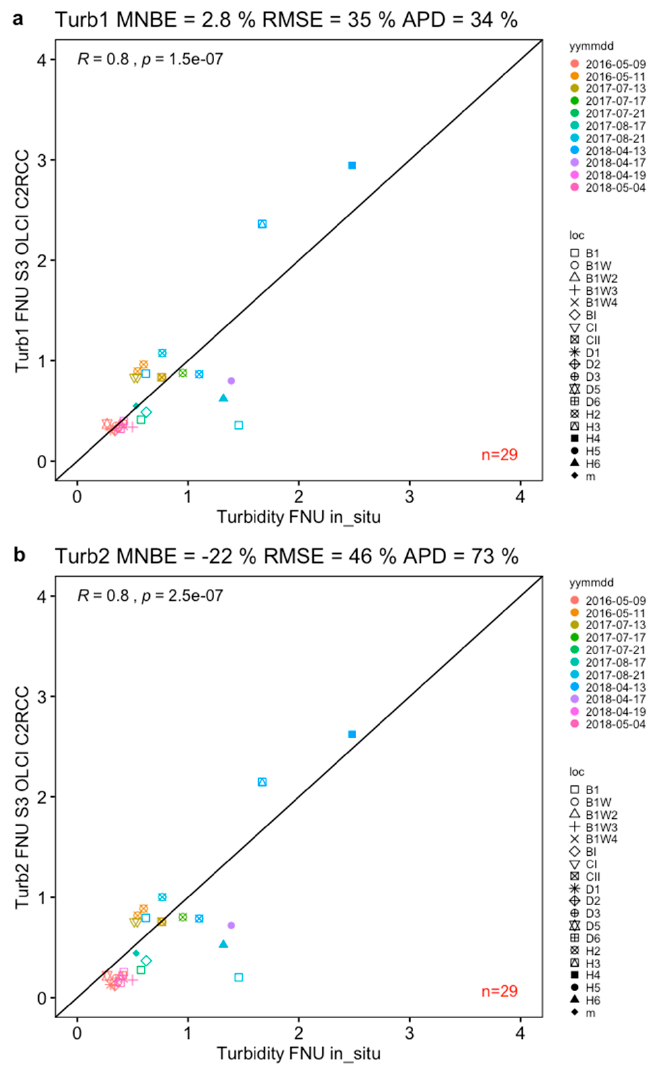
Figure 8. Turbidity products ( a ) Turb1 and ( b ) Turb2 derived from “iop_bpart” using the algorithms described above and applied to S3A OLCI data generated by the C2RCC-SNAP with locally adapted parameters and both compared to in situ turbidity.